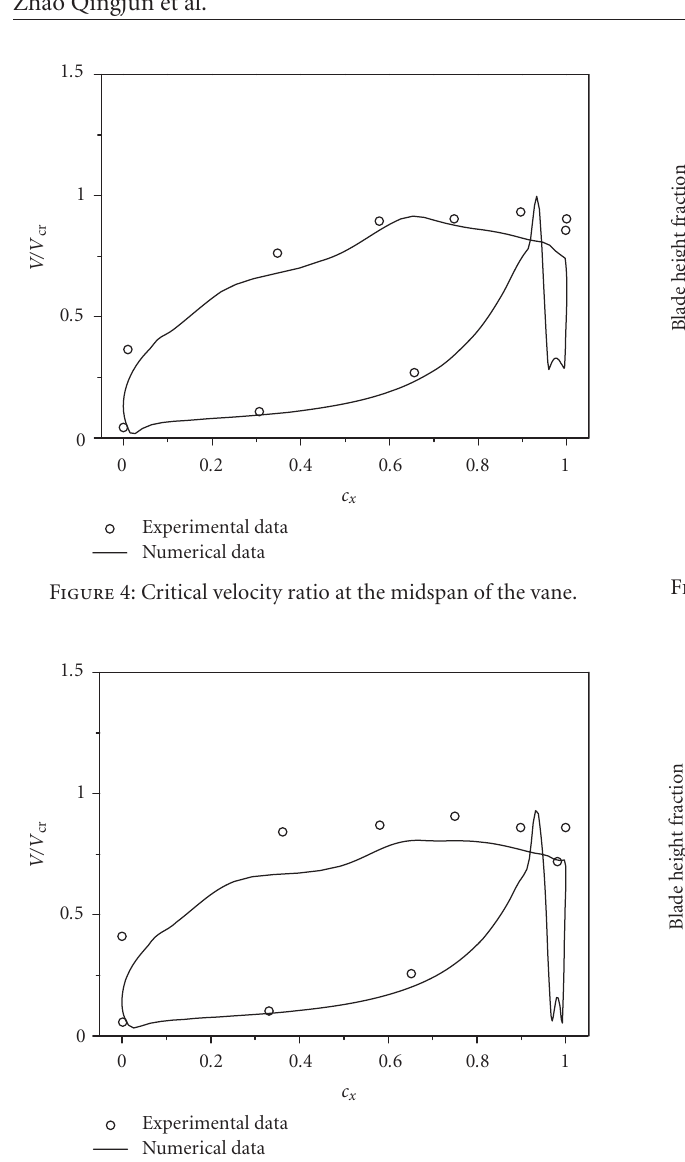
Figure 7: Total temperature distribution at the outlet of the